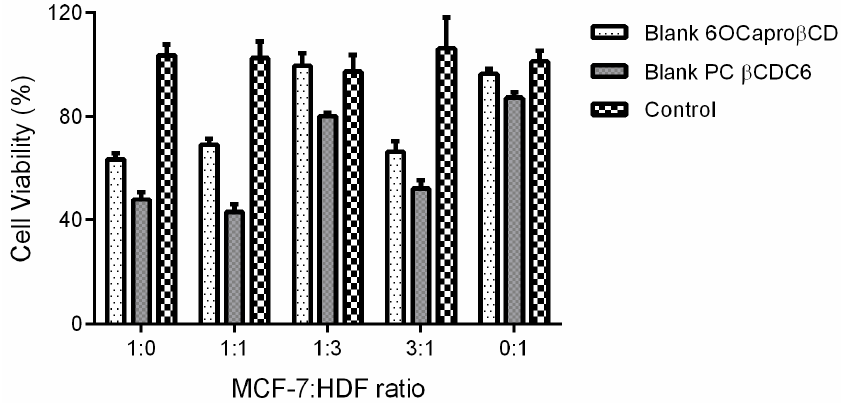
Figure 8. Antiproliferative effect of blank amphiphilic cyclodextrin (CD) nanoparticles on MCF-7: HDF co-culture ( n = 6, ±SD).